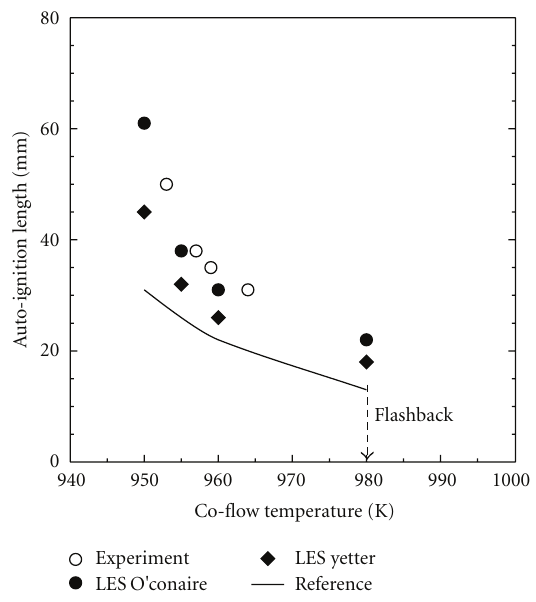
Figure 6: LES autoignition locations. Reference: minimum autoignition length ( l ign,ref ) using ´O Conaire mechanism [22].